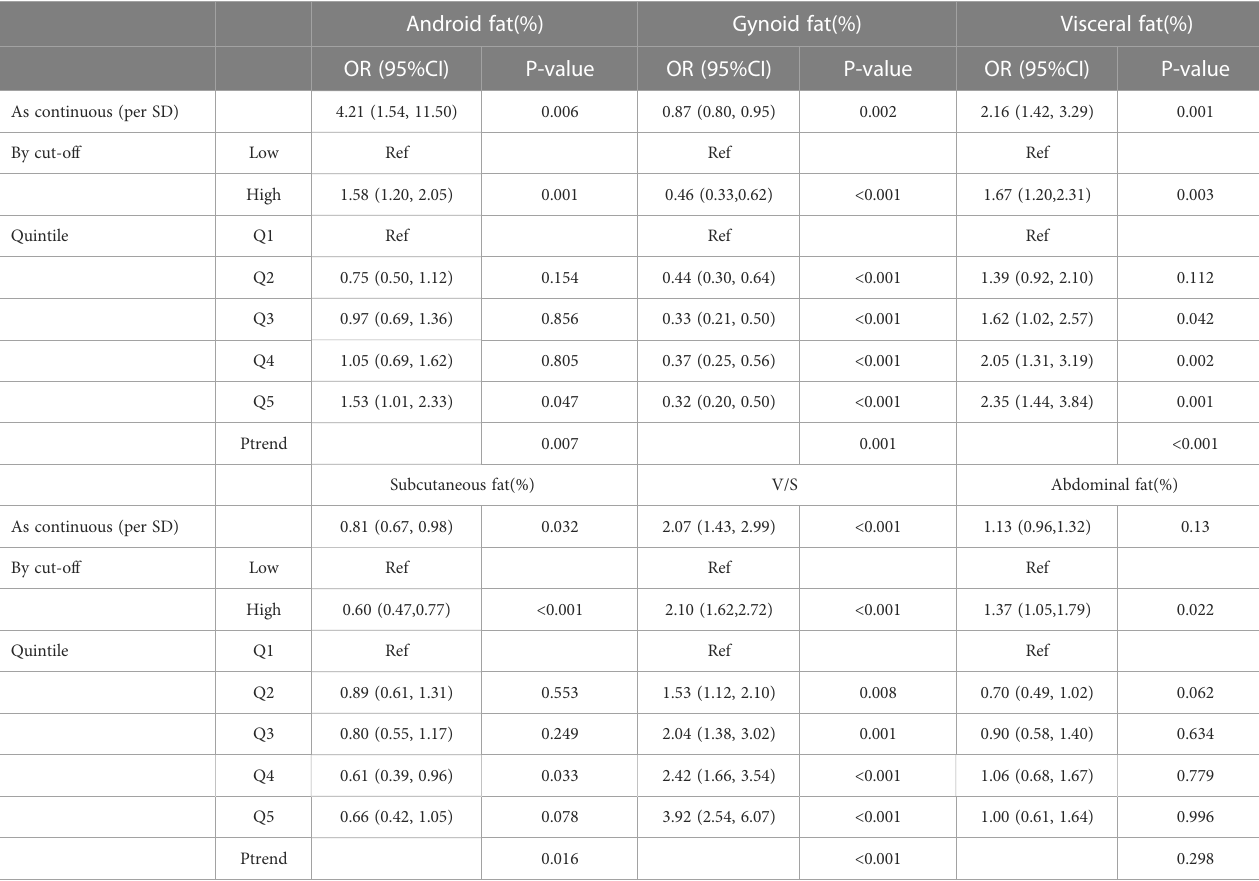
TABLE 2 Odds ratio (95%CI) of comorbidity risk with different fat distribution in male obese